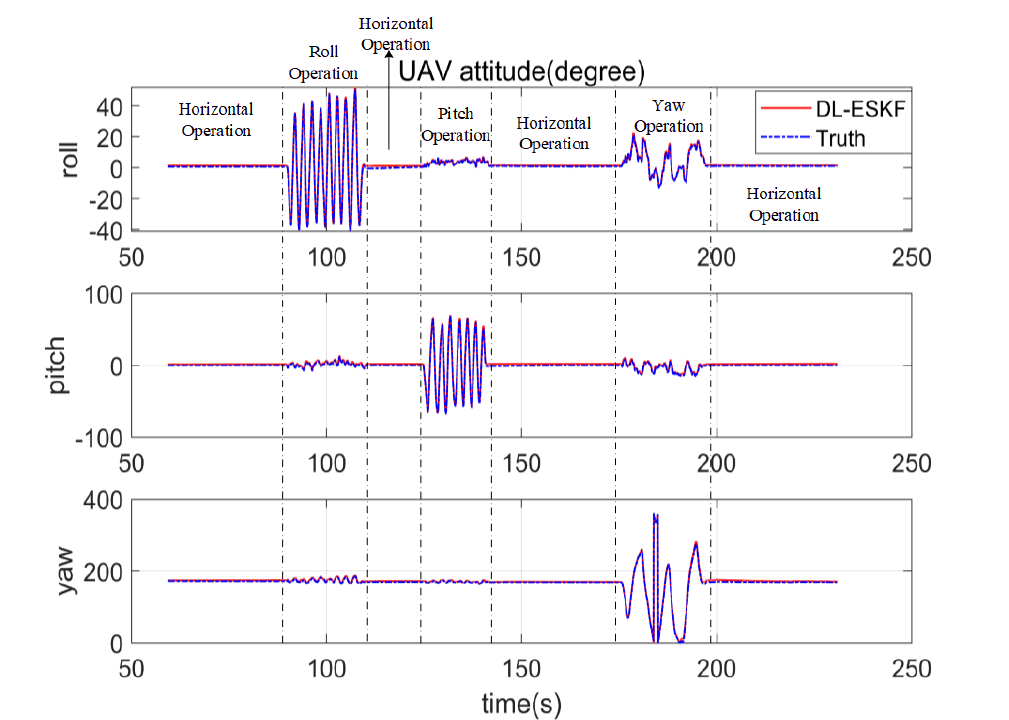
Figure 20. Dynamic flight attitude changes.